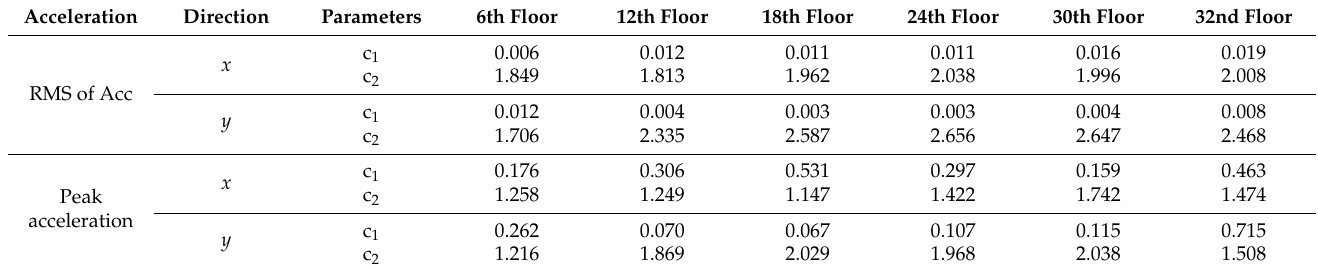
Table 2. The fitting results of translational parameters of c 1 and c 2 .